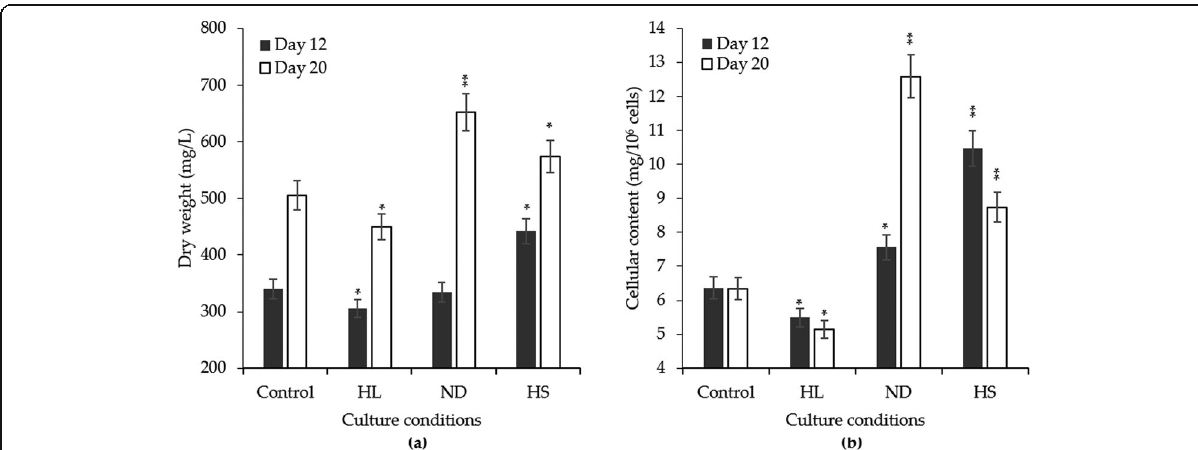
Fig. 2 Dry weight and cellular content of D. salina Y6 under the tested abiotic-stress conditions. a Dry weight of D. salina Y6. b Cellular content of D. salina Y6. HL, high-light conditions ; ND, nitrogen-depleted conditions; HS, high-salt conditions. ** p < 0.01, * p < 0.05. The values represent mean ± S.D. ( n =